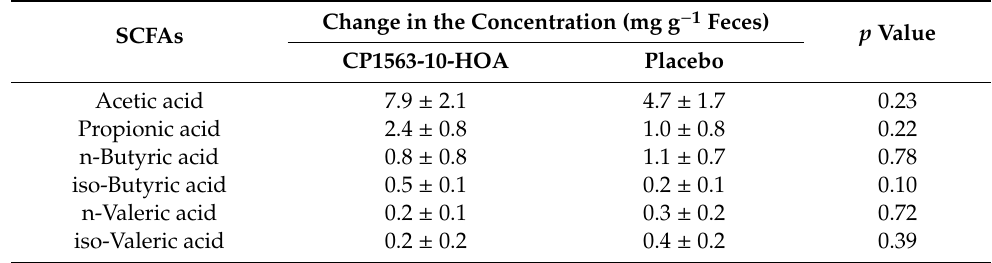
Table 4. Changes in the concentrations of fecal short chain fatty acids (SCFAs).